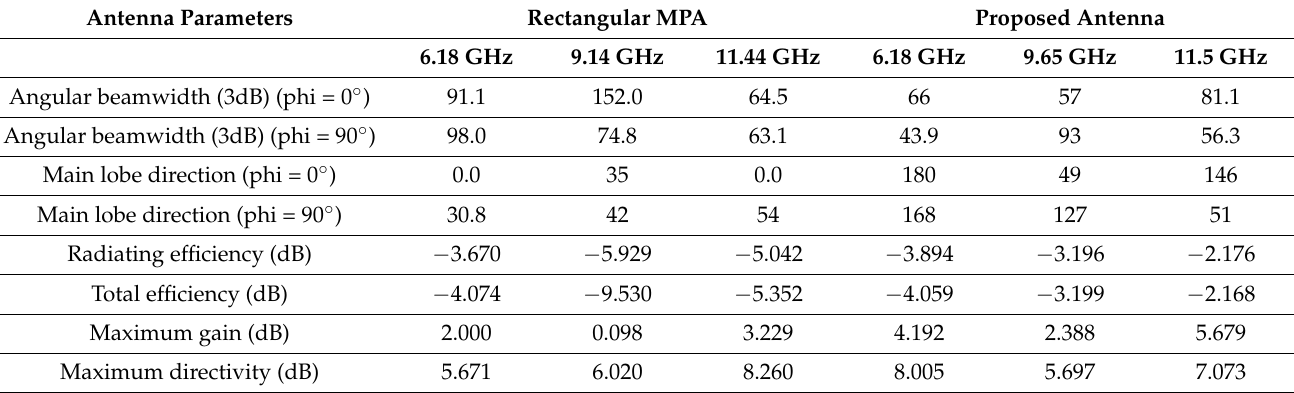
Table 6. Radiation parameters of the I-shaped MTM-based rectangular